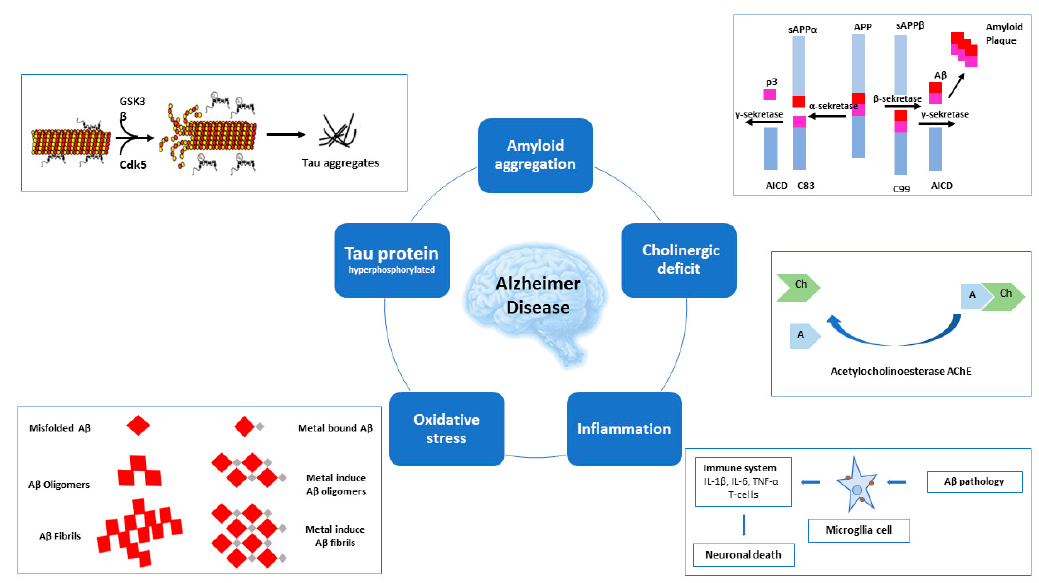
Figure 1. Multiple pathological pathways of AD.